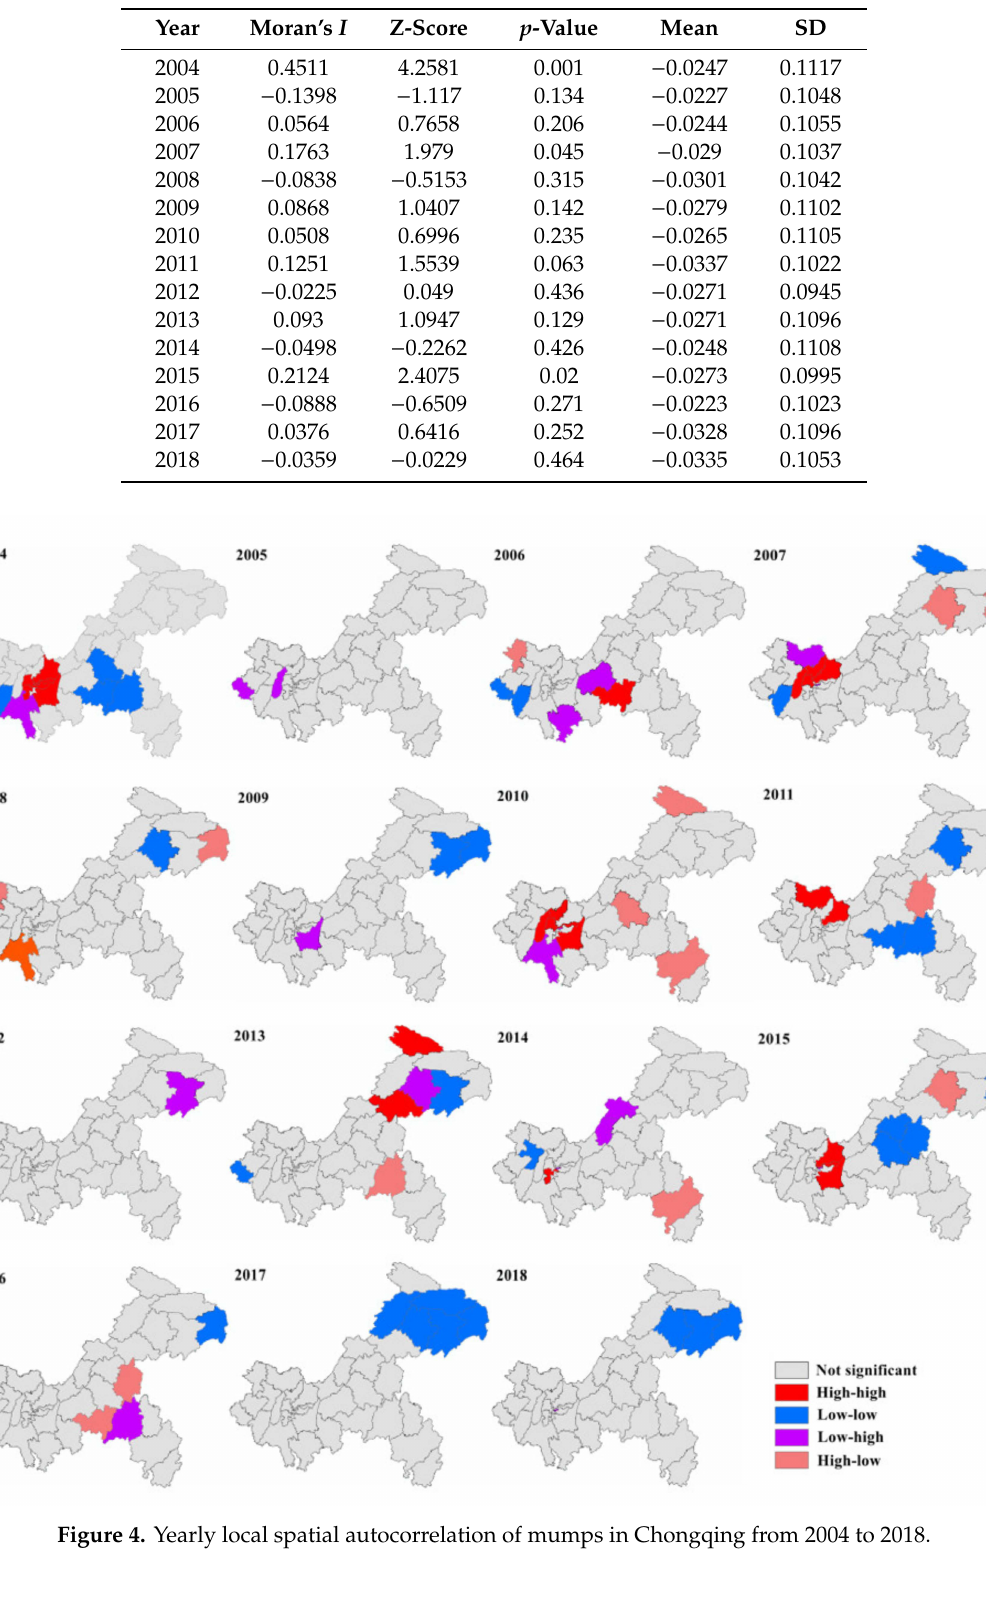
Table 1. Global spatial autocorrelation of mumps in Chongqing from 2004 to 2018.